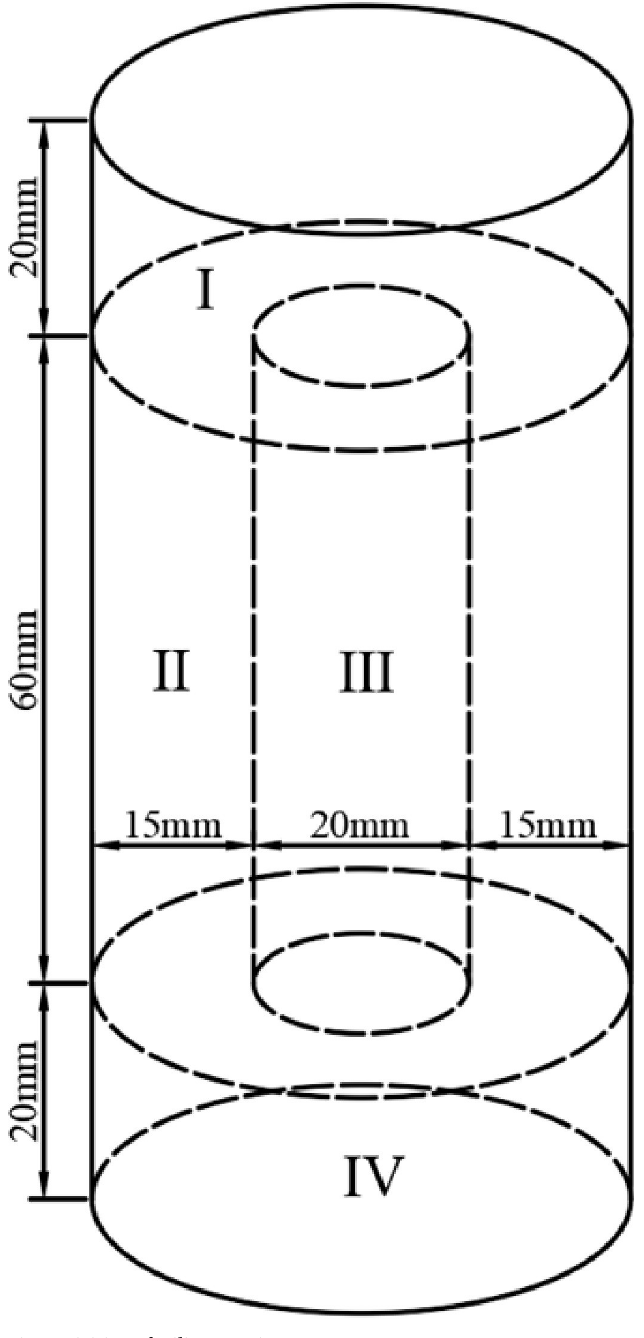
Fig 6. Division of tailings